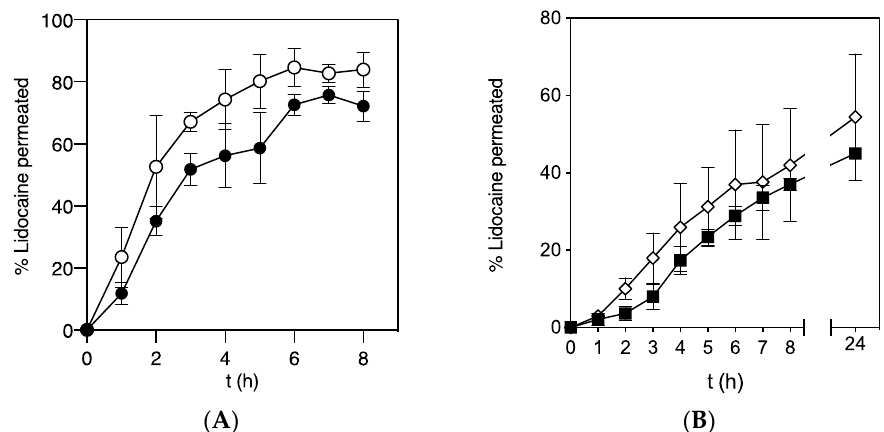
Figure 6. Permeability of LID through a bioengineered skin substitute comparing ( A ) the permeability of LID released from GMS-LID4 particles (squares) and LID powder (diamonds) in Franz cell experiments ( n = 4), and ( B ) the permeability of LID released from GMS-LID4 particles through complete skin tissue (epidermal and dermal layers, black circles) and dermal layer (white circles) ( n = 3).